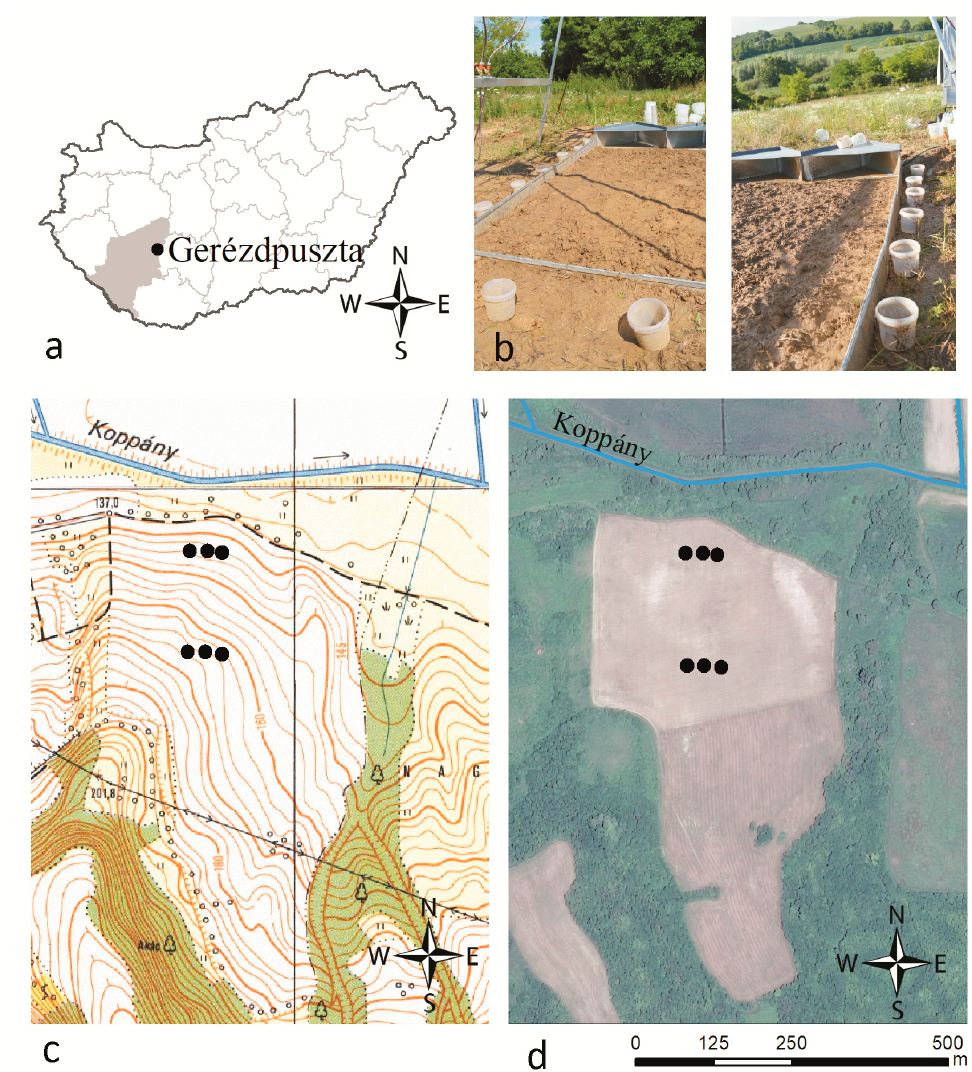
Figure 1. Location of the field experiment and the collection of soil samples for the laboratory simulations in Hungary (Europe) at Gerézdpuszta settlement in Somogy county (area highlighted grey) ( a ). Field rainfall simulation ( b ), the topography ( c ), and the land use ( d ) of the investigated catena. Black dots indicate the locations of the field rainfall simulation plots.